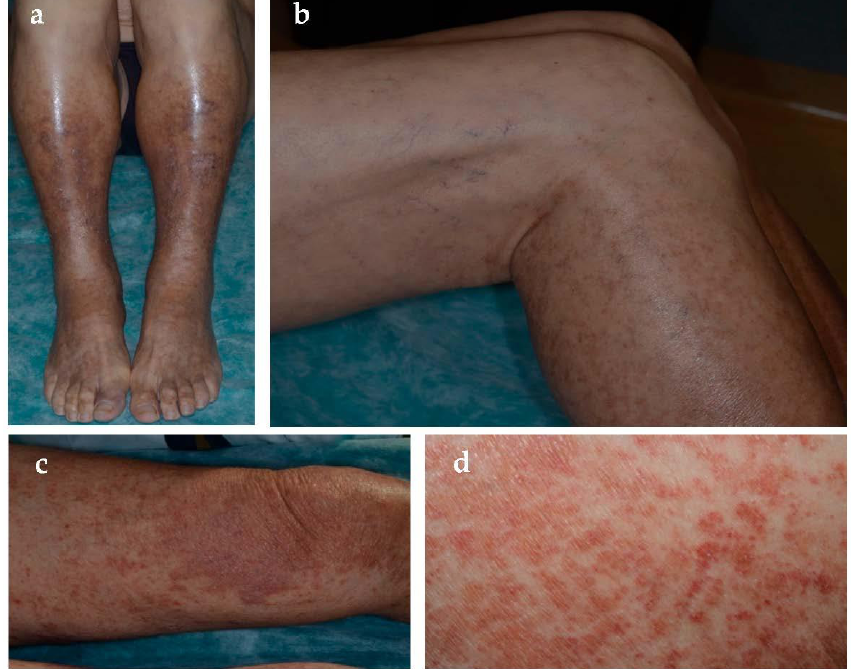
Figure 2. Schamberg disease. ( a , b ) Lower leg localization of petechiae superimposed on diffuse hemosiderin deposits in venous hypertension. Proximal extension towards thighs is visible. ( c , d ) Discrete yellow-red patches with superimposed petechiae.